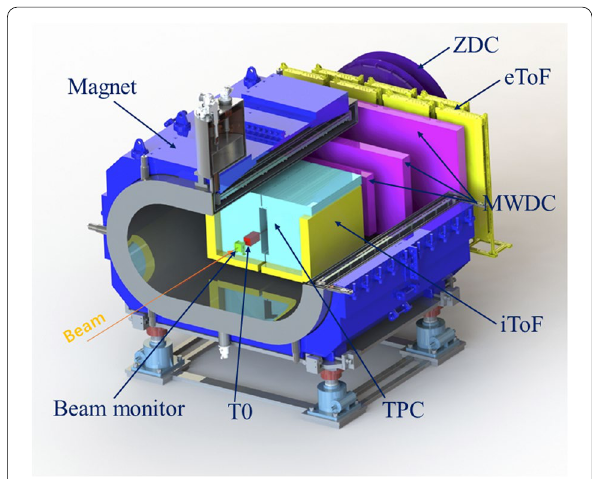
Fig. 7 The external target experiment setup with major components